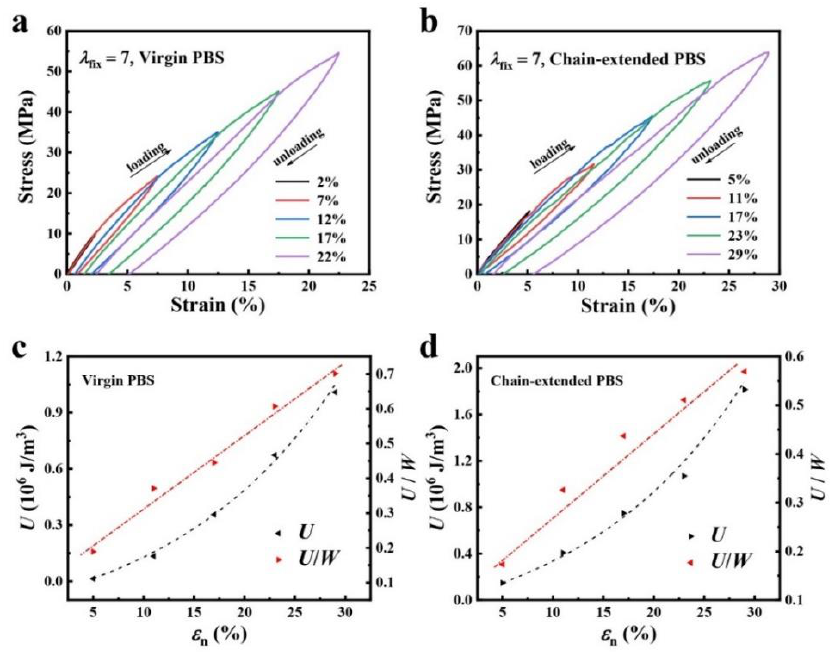
Figure 3. Cyclic tensile and energy release rate of PBS samples. Hysteresis curves of virgin samples ( a ) and chain extension states ( b ) with various strains and cyclic tensile loading – unloading curves. Virgin PBS and chain-extended PBS samples were stretched five times in cycles before the maximum critical strain ε n , recorded as ε 1 , ε 2 … and ε 5 . The corresponding dissipated energy ( U ) of one loop at different maximum strain ε max , recoded as U 1 , U 2 … and U 5 . The relationship between the ratio of dissipated energy to tensile work U / W t and strain of the virgin state ( c ) and chain extension state ( d ). The loading and unloading stretch rates were 5 mm min − 1 .